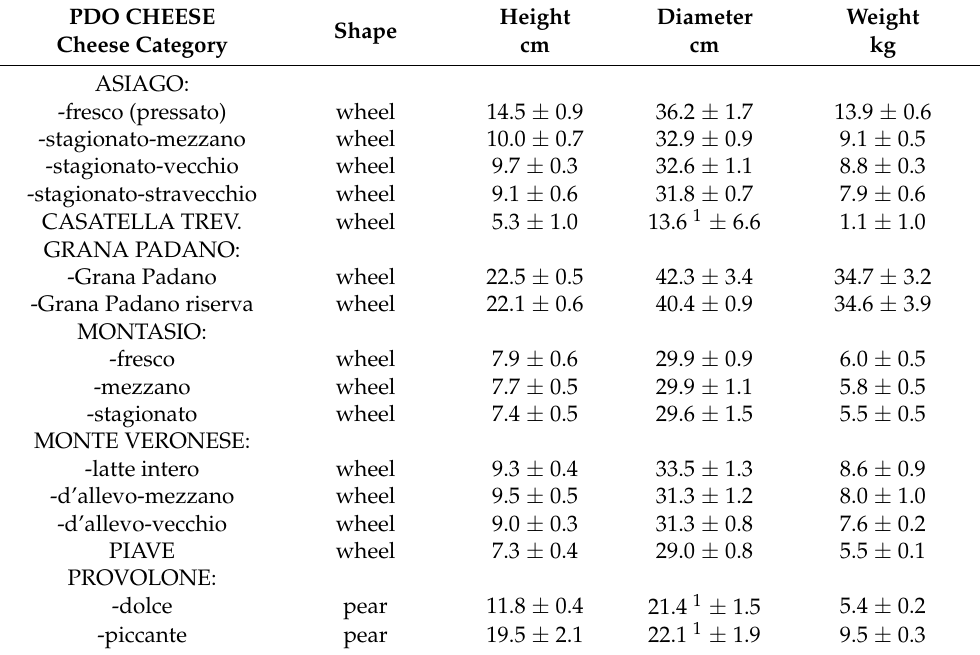
Table 3. Shapes and sizes of the cheeses with EU Protected Designation of Origin (PDO) status (averages and standard deviations by cheese